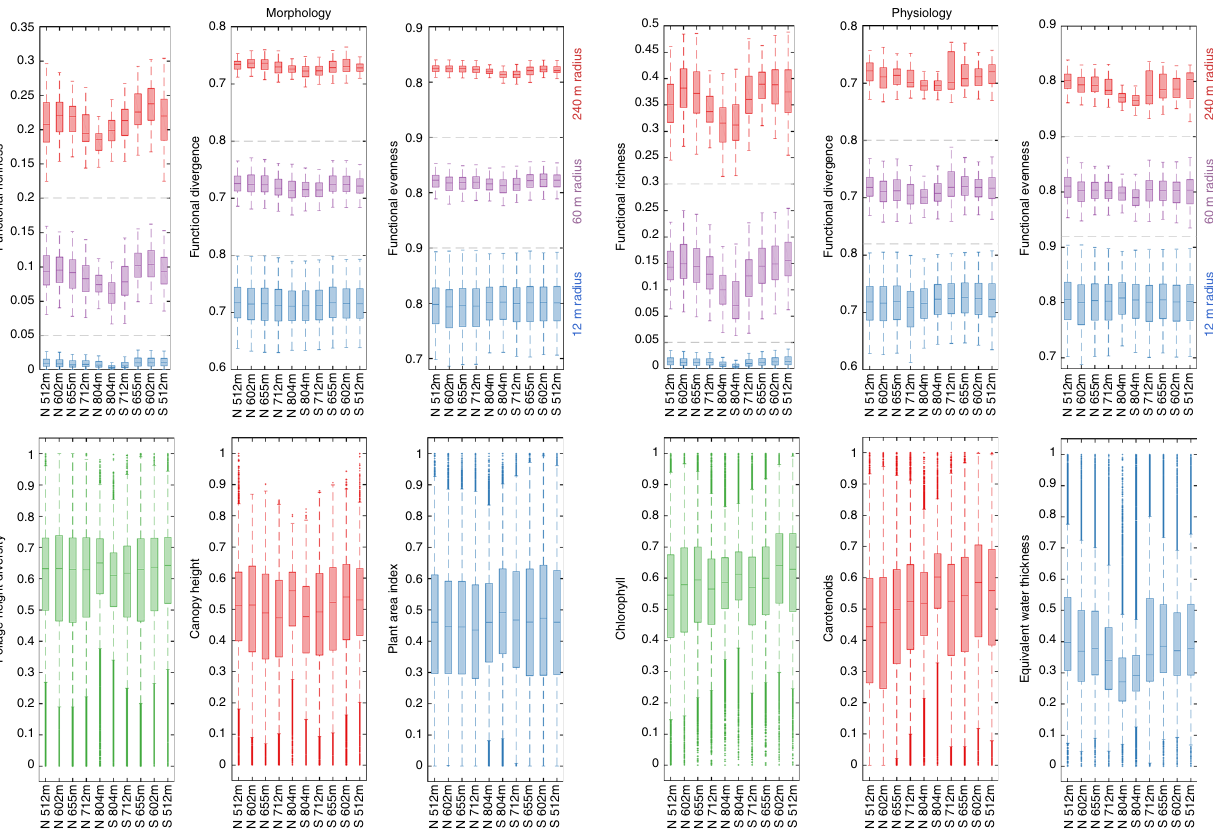
Fig. 4 Boxplots of functional diversity indices and traits grouped by altitudinal belts. Functional richness, divergence and evenness (top panel) are shown for three spatial scales at 12 m (blue), 60 m (purple) and 240 m (red) radius. Underlying functional trait values are displayed below, with morphological traits on the left and physiological traits on the right side. Boxes show the median and ± 1 standard deviation and whiskers mark ± 2 standard deviations. Altitude values on the x -axis of the boxplots indicate the middle of the altitudinal belt for the north (N) and the south (S) side of the mountain ridge